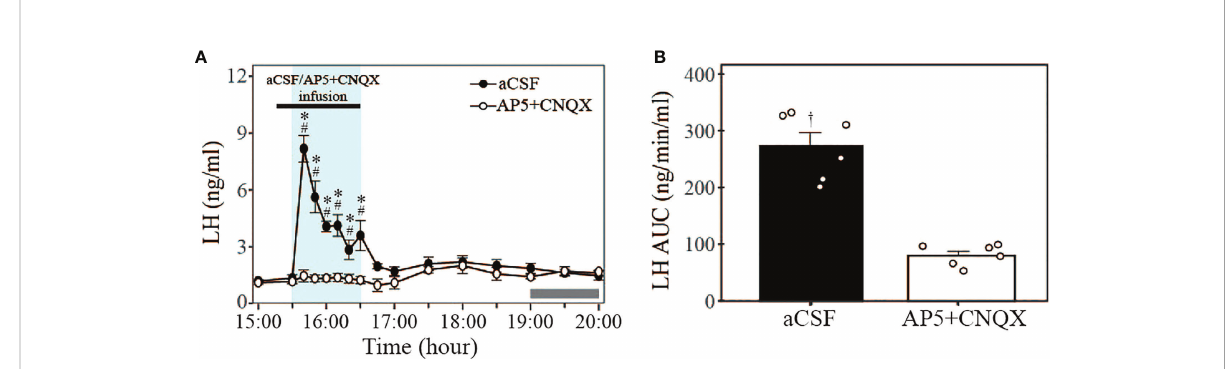
FIGURE 5 Effect of glutamate antagonism on LH secretion induced by 20 Hz optical stimulation of Kiss1 ARC neuron terminals in the AVPV in proestrous Kiss-Cre-tdTomato mice. (A) Circulating levels of LH (Mean ± SEM) in response to 1-h 20 Hz optical stimulation (15:30 – 16:30 h) in the presence of intra-AVPV administration of glutamate antagonists (AP5+CNQX) (white circle) or arti fi cial cerebrospinal fl uid (aCSF) as control (black circle). The combined NMDA and AMPA receptor antagonists were infused from 15:20 to 16:30 h (black rectangle, bolus over 10 min followed by continuous infusion over 60 min: AP5, 1.2 + 2.0 nmol; CNQX, 0.5 + 1.0 nmol, respectively). (B) The AUC for LH secretion during a 1-h optic stimulation (15:30 – 16:30 h) at 20 Hz in the presence of intra-AVPV administration of AP5+CNQX or aCSF in proestrous Kiss-Cre- tdTomato mice. Individual data points were shown as black circles. Grey bar on abscissa represents the light-off. *P < 0.05 relative to baseline LH levels at 15:00 h (-30 min). # P<0.05 represents signi fi cant differences of LH levels in control group relative to antagonist group. † P < 0.05 LH AUC for AP5+CNQX vs aCSF. n = 6 per treatment